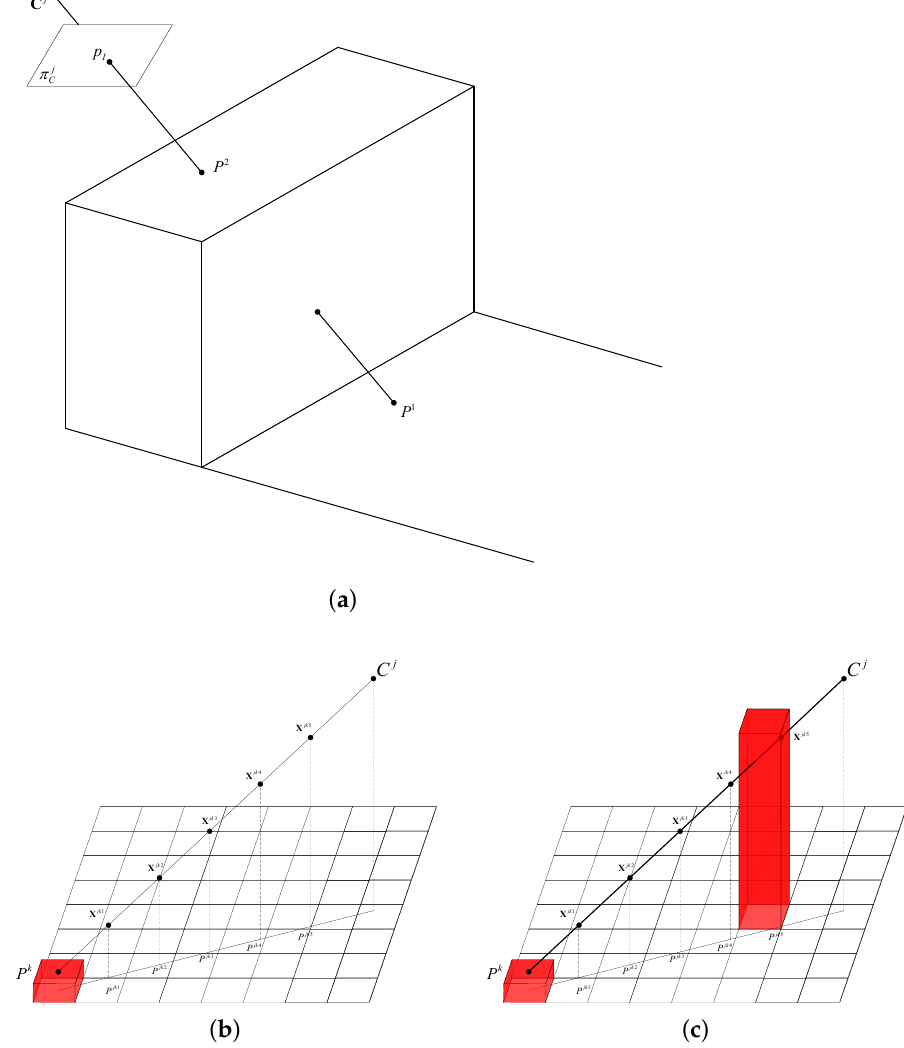
Figure 6. Figures to display the occlusion detection process. ( a ) A demonstration of the occlusion problem. ( b ) Figure to explain the sampling method of points on the connecting line between the cell P k and the camera center C j . The distance between neighbor sampled points is the sample interval, L S . To highlight the process of the point sampling, cells other than P k are not drawn in this figure. ( c ) An example of the occlusion detection process. Because the elevation of P jk 5 is higher than the Z-coordinate of X jk 5 , the image I j is judged as an occluded image. However, if the cell P k is used for propagation before the elevation of P jk 5 is known, the occlusion would not be correctly